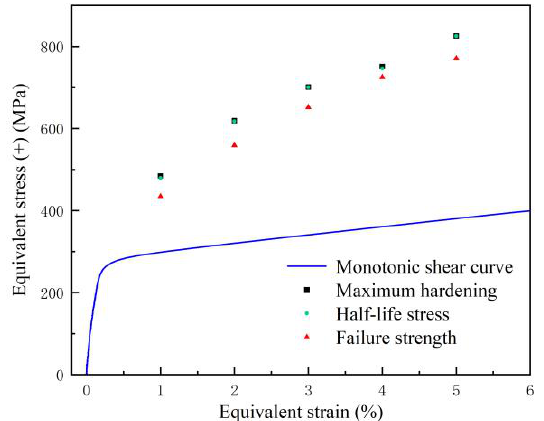
Figure 7. Monotonic shear curve, maximum hardening, half-stress, and failure strength relationship for 316L under cyclic shear path .